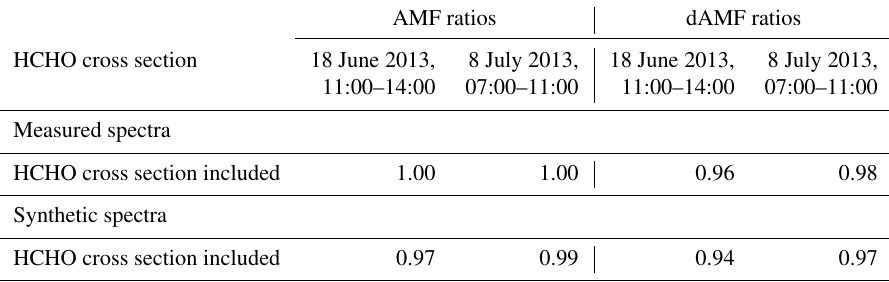
Table A22. Average ratios of O 4 (d)AMFs derived for the analysis including a HCHO cross section vs. those for the standard analysis (no HCHO cross section) (only one O 4 cross section) for the middle period on each selected day (top: results for spectra measured by the MPIC instrument; bottom: results for synthetic spectra when taking into account the temperature dependence of the O 4 cross